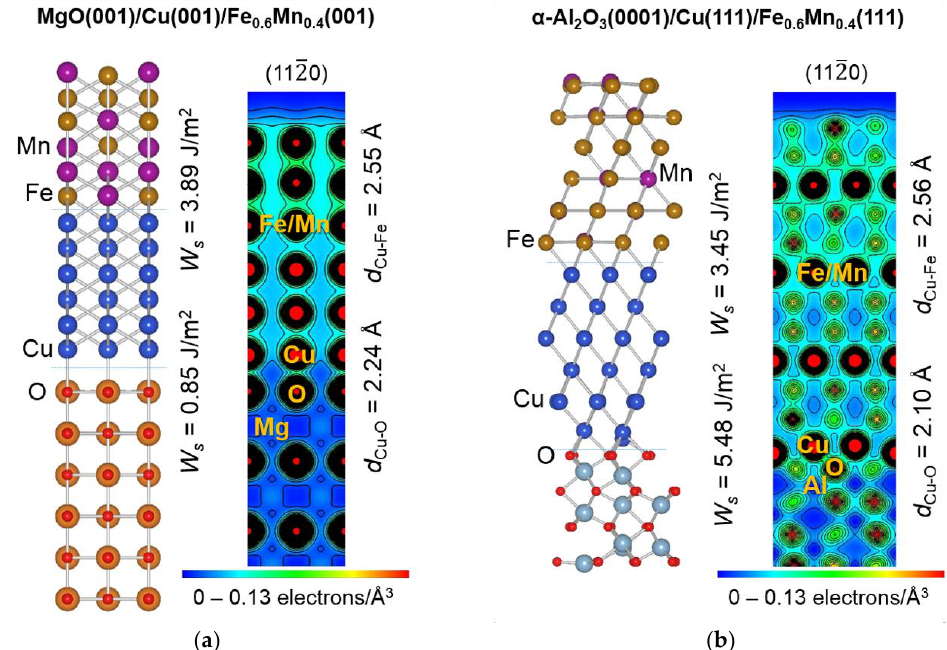
Figure 1. Structural models of ( a ) MgO(001)/Cu(001)/Fe 0.6 Mn 0.4 (001) and ( b ) α -Al 2 O 3 (0001)/Cu(111)/Fe 0.6 Mn 0.4 (111), each with corresponding electron density distribution in a ( 112̅0 ) plane of the substrate. The work of separation ( W S ) and bond length ( d ) at the interfaces are also provided.